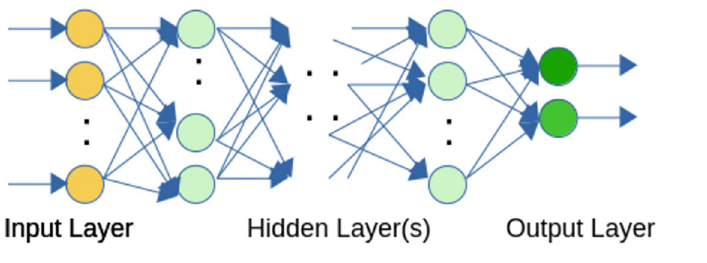
Fig 5. A feed-forward neural